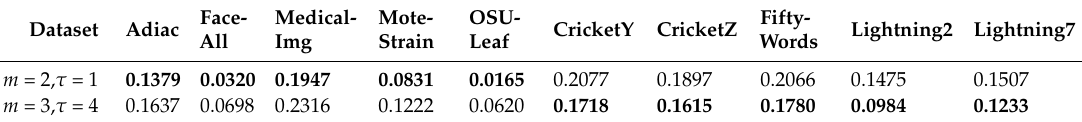
Table 3. Comparison in terms of error rates between different m and τ .